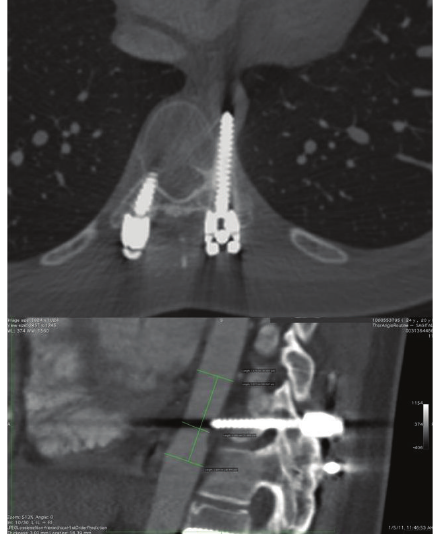
Figure 1: Preoperative CTA reveals the presence of the pedicle screw at the T10 level of the thoracic aorta.